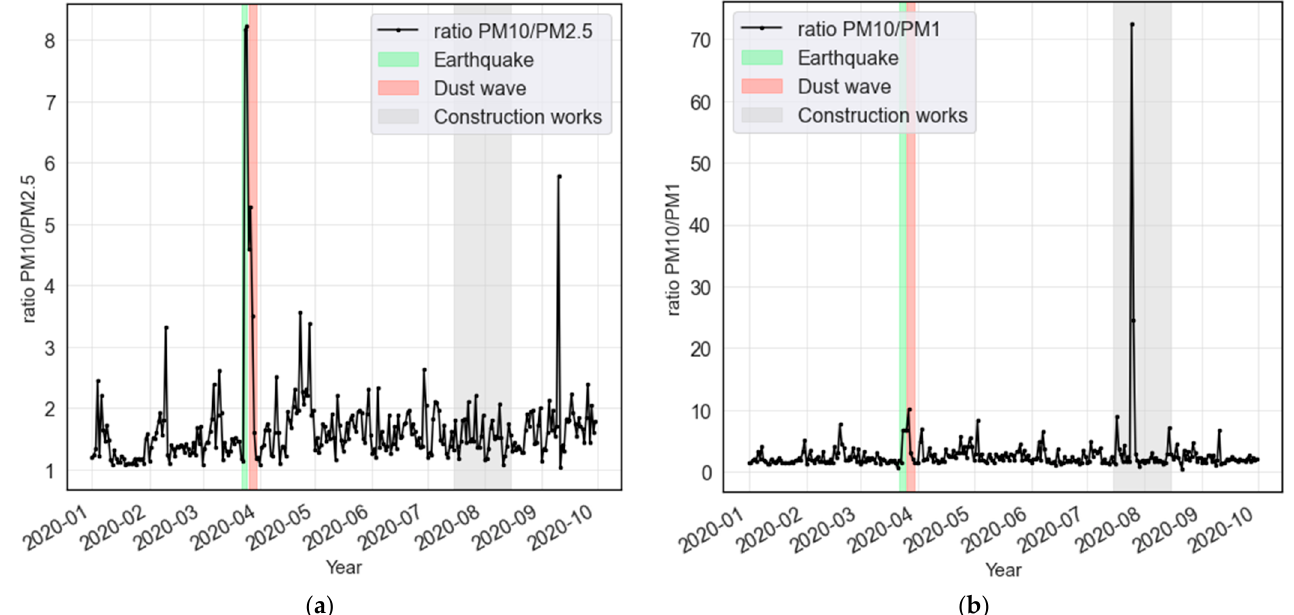
Figure 3. Out-of-ordinary events during 2020 shown as ratio between: ( a ) PM 10 /PM 2.5 and ( b ) PM 10 /PM 1 . The events in March 2020 are assigned to either the Zagreb-earthquake on 22 March, the sand dust event between 24 and 30 March, or construction works at the site in early March, August, and September. These events were excluded from the analyzed timeframes.